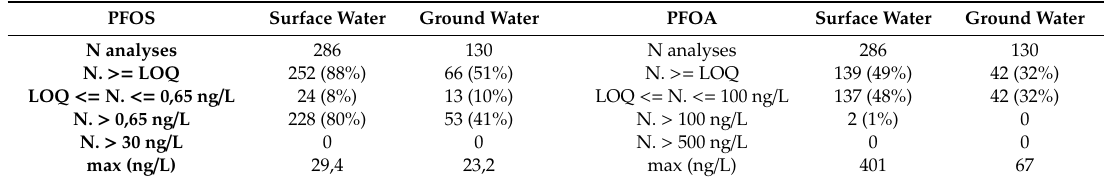
Table 9. PFOS and PFOA distribution in surface and ground water